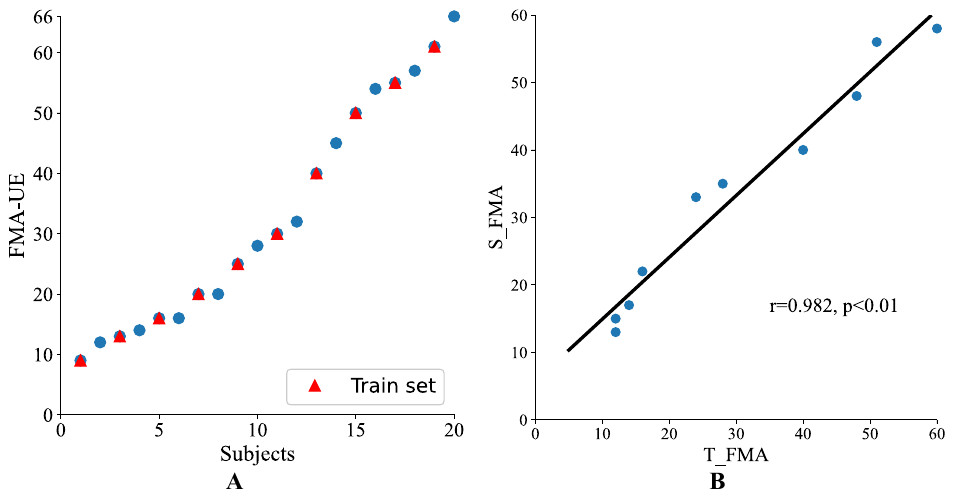
Figure 5. ( A ) The FMA-UE scores of 20 subjects. The subjects with red triangle markers were regarded as the training set in the simulated online test, and other subjects were used as the test set. ( B ) Simulated online test results, the correlation between the total scores of the 30 items obtained by the automated system and by a therapist in the test set ( n =